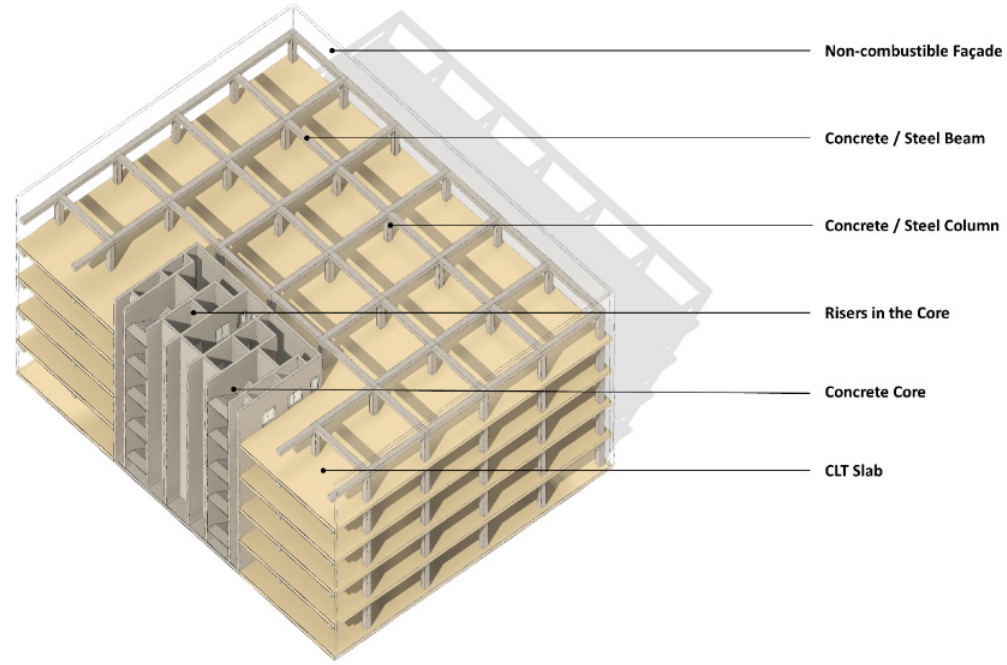
Figure 1. Illustration of a hybrid commercial structure, utilising CLT as floor members.